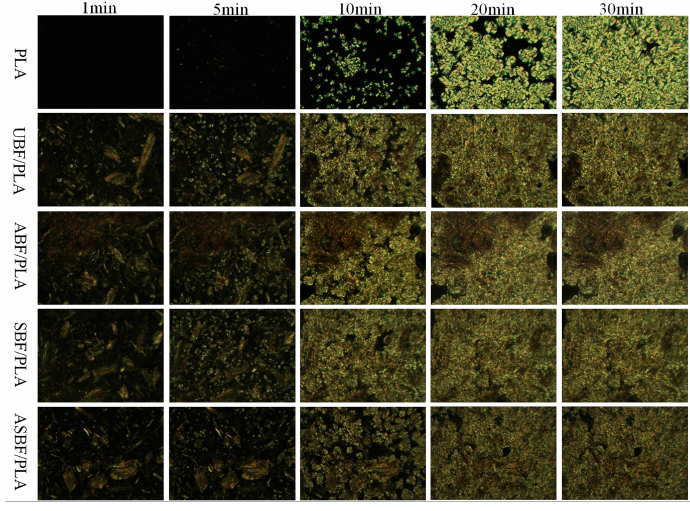
Figure 7. POM images of BF/PLA composites with different modified BF.